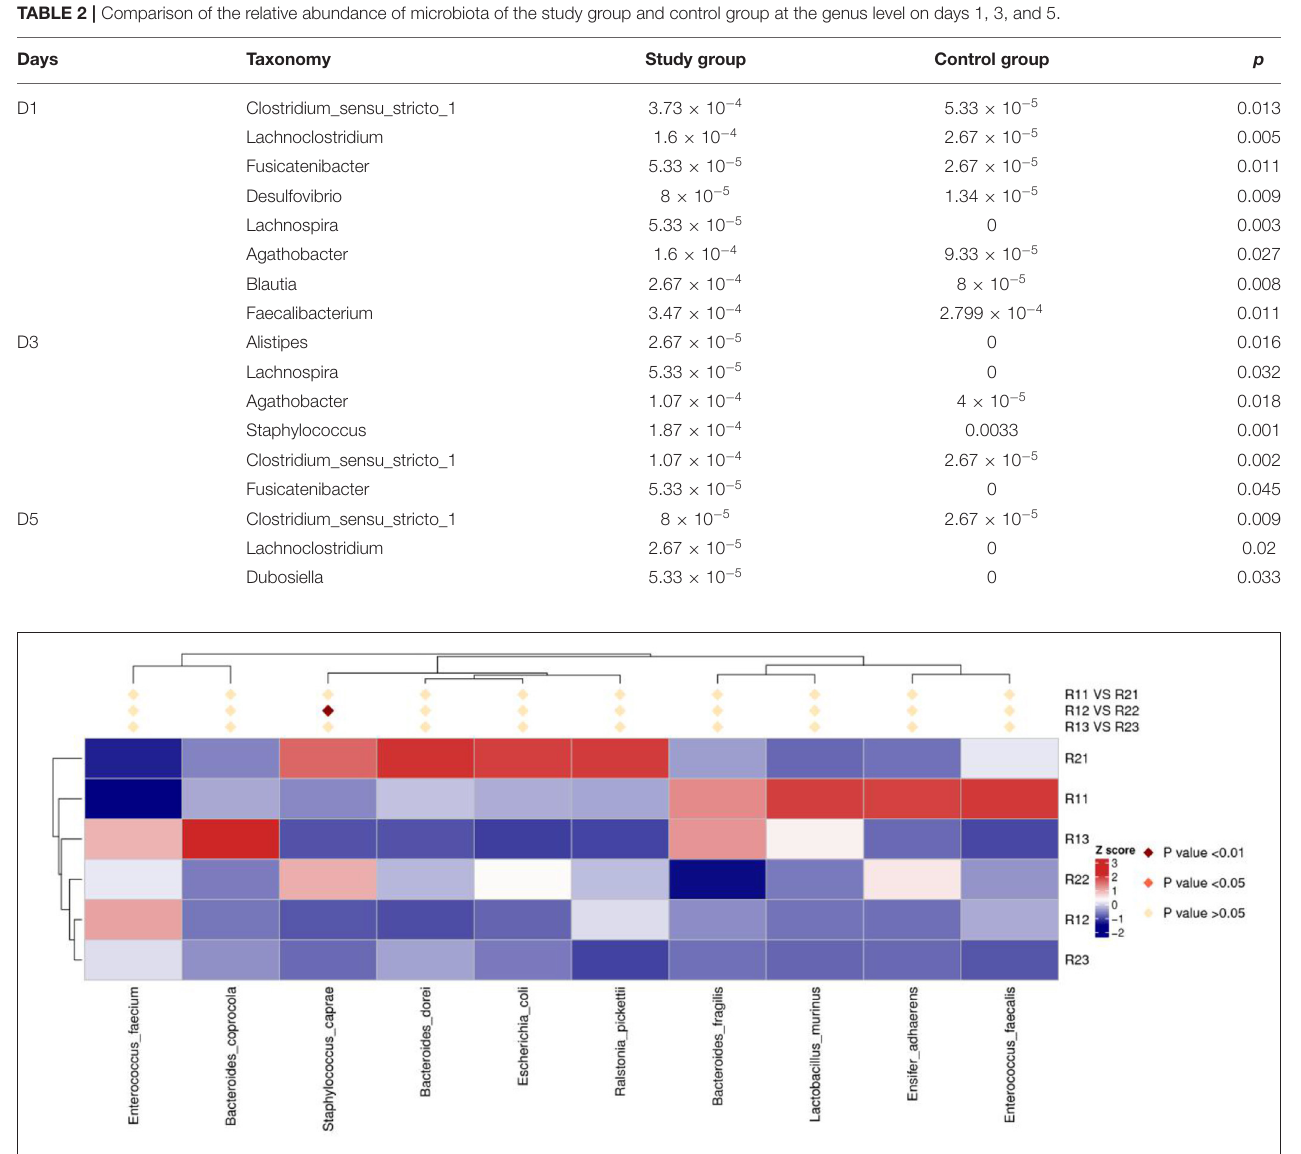
FIGURE 3 | Results of heatmap analysis of species with significant differences at the species level. R11, gut flora of the study group on day 1; R21, gut flora of the control group on day 1; R12, gut flora of the study group on day 3; R22, gut flora of the control group on day 3; R13, gut flora of the study group on day 5; R23, gut flora of the control group on day